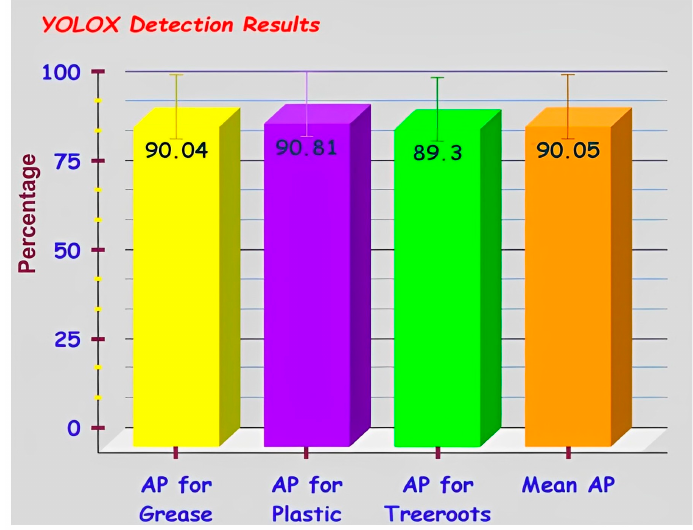
Figure 18. YOLOX detection results for all classes in S-BIRD.